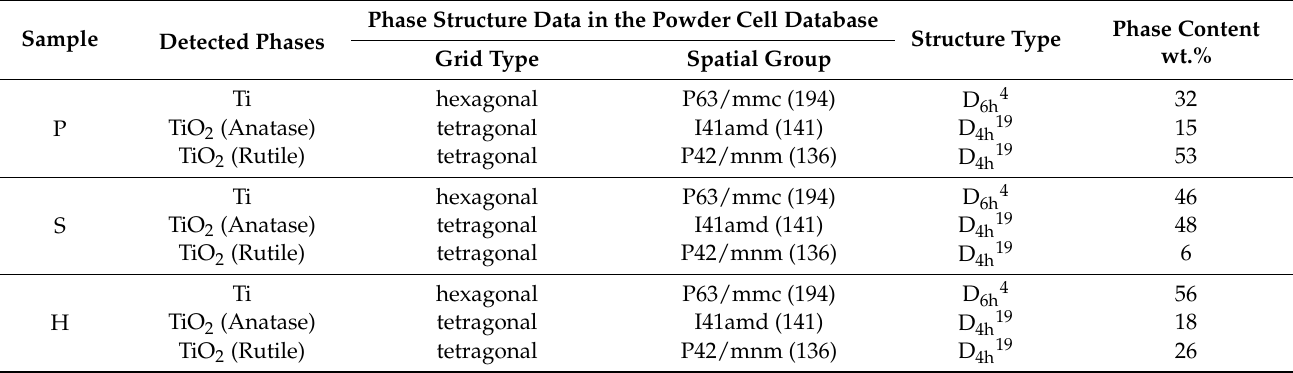
Figure 6. X-ray diffraction patterns of PEO coatings obtained in various electrolytes: ( a ) H; ( b ) S; ( c ) P. Table 3. X-ray phase analysis